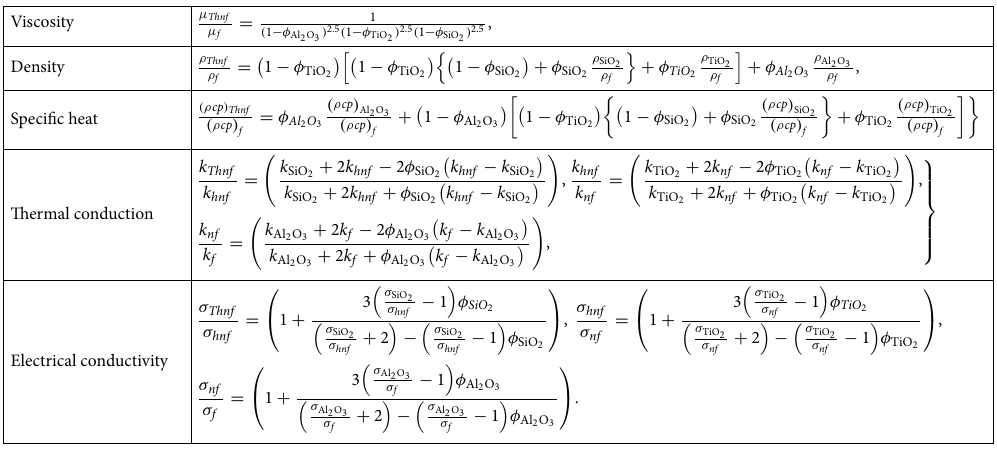
Table 2. The thermal properties of trihybrid nanoliquids 40 .